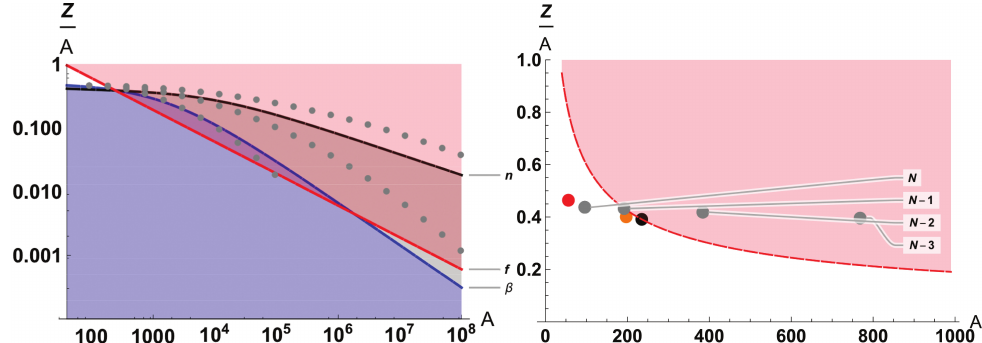
Figure 2. Both Panels: Evolution “jumps” in fission cascades (from right to left), starting from an initial giant nucleus ( A ∼ 10 8 ) and, in a couple of dozens of splits (gray dots), leading to 92 Mo (final left gray dot). For each “daughter”-nucleus, the “ancestor” simply splits in two (and a parametrized adjustment for the “loss” of neutrons due to n - and β -emissions is included at each fission event). Critical lines (where binding energy B have extrema, i.e., ( ∂ i B ) j = 0 with indices i , j denoting nucleon numbers Z , N , A = Z + N ) are depicted as: β -line (blue), n -line (black), and fission-limit f -line (red). (see Ref. [7] for derivations and details.) In the shaded red zone, fission takes place. In the shaded gray zone, n -emission takes place. In the shaded purple zone, β -emission takes place. Right Panel: Zoom into A < 1000 only (not logarithmic but liner scale): the final stage of the fission-cascade leading to 92 Mo. Gray dots show 92 Mo (label N) and its last three generations of “ancestors” (N-1, N-2, N-3). Placements of Fe (red dot), Au (yellow dot), and U (black dot) are also